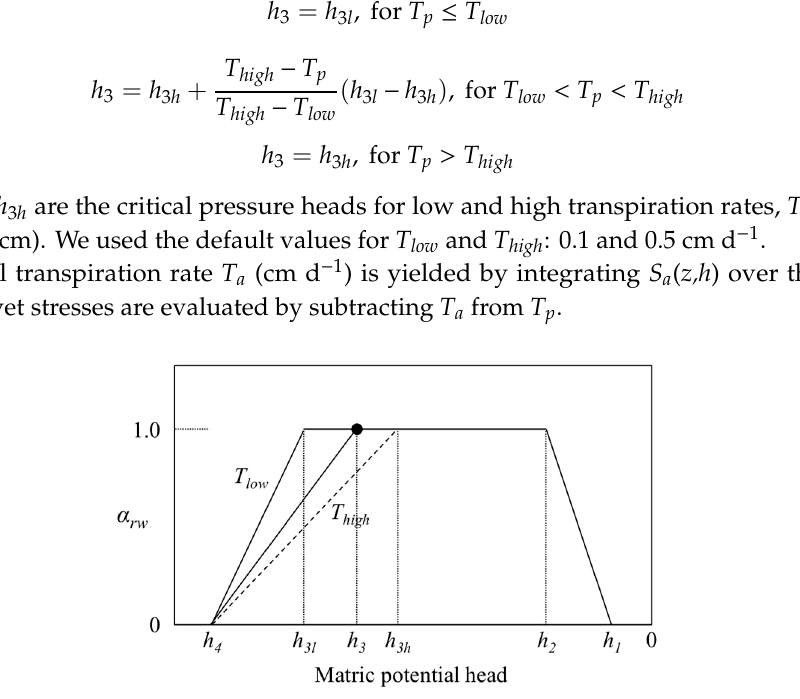
Figure 1. The reduction factor for excessive wet and dry conditions, α rw , as a function of matric potential head; h 1 , h 2 , h 3 , and h 4 are critical pressure heads ( − cm); h 3 is between h 3 h and h 3 l values